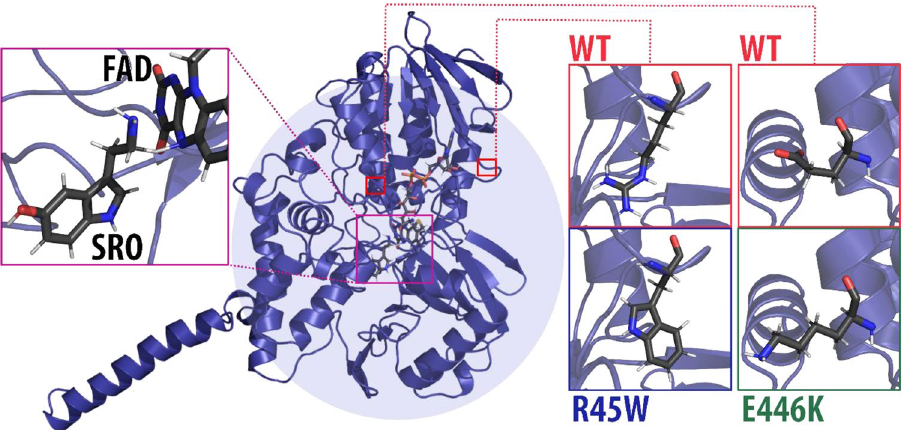
Figure 1. Monoamine oxidase enzyme with serotonin (SRO) docked in the active site (shown in inset on the left) and reacting with the flavin adenine dinucleotide cofactor (FAD). The locations of the mutated residue of two mutation variants (R45W and E446K) are marked with red squares. In R45W amino acid arginine from the wild type enzyme (WT) is replaced by tryptophan, whereas in E446K glutamate is replaced by lysine.